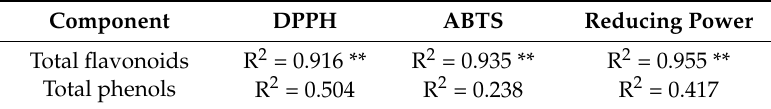
Table 6. The correlation between DPPH, ABTS, ferric reducing capacity with total flavonoids and total phenols.